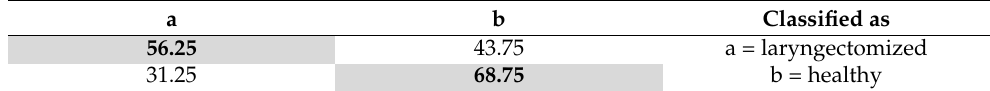
Table 6. Error matrix for the classification of the second phonetic segment. Used k-NN, cross- validation method (k = 10). General recognition 62.5%.